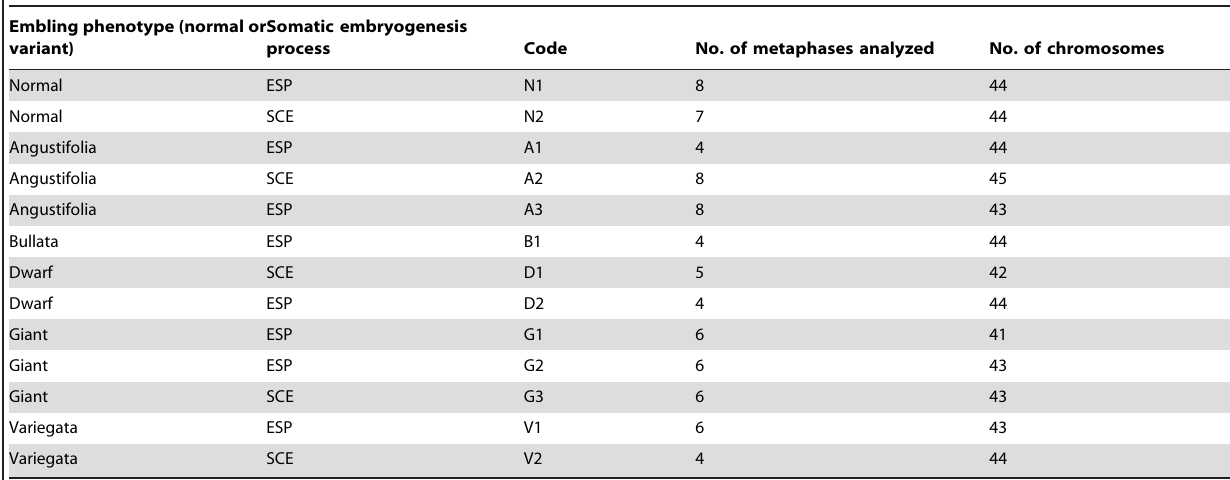
Table 7. Summary of chromosome counting in some normal versus variant C. arabica hybrids derived from somatic